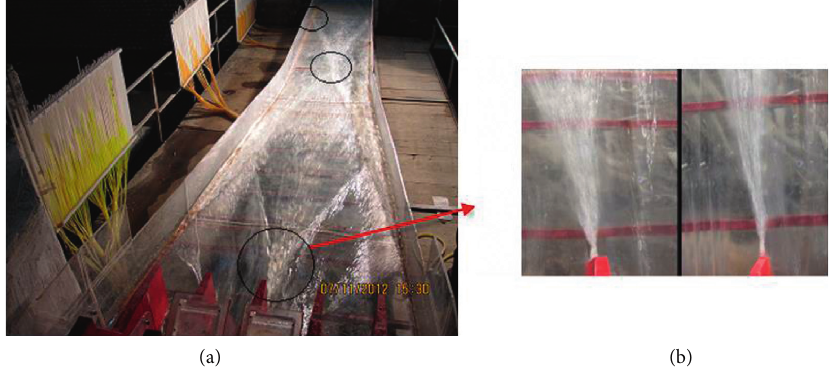
Figure 11: Wave 1 plan view: (a) Fr